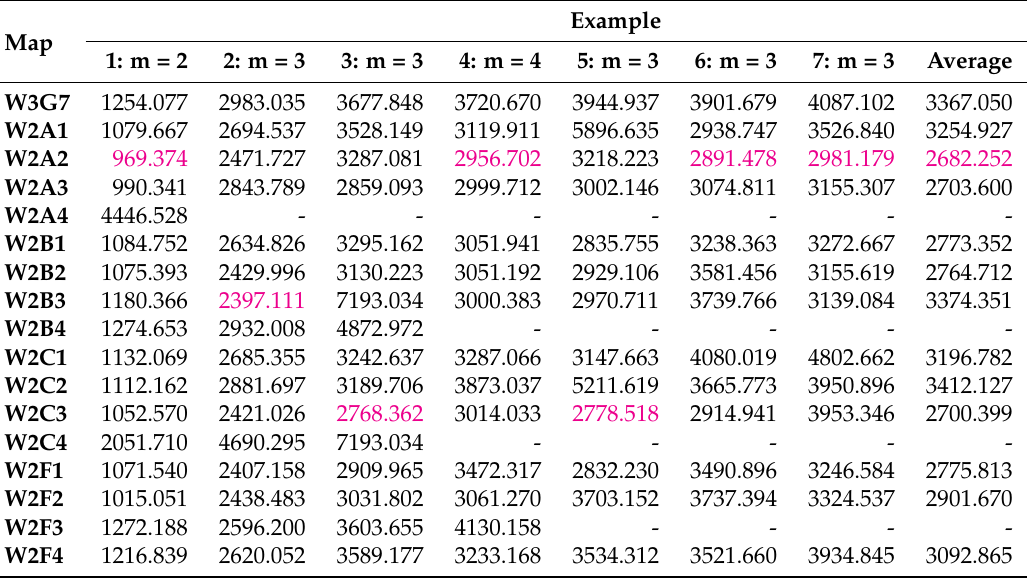
Table 6. CPU time (in seconds) required for each example(1–7) using a Dell Multiplex-990.